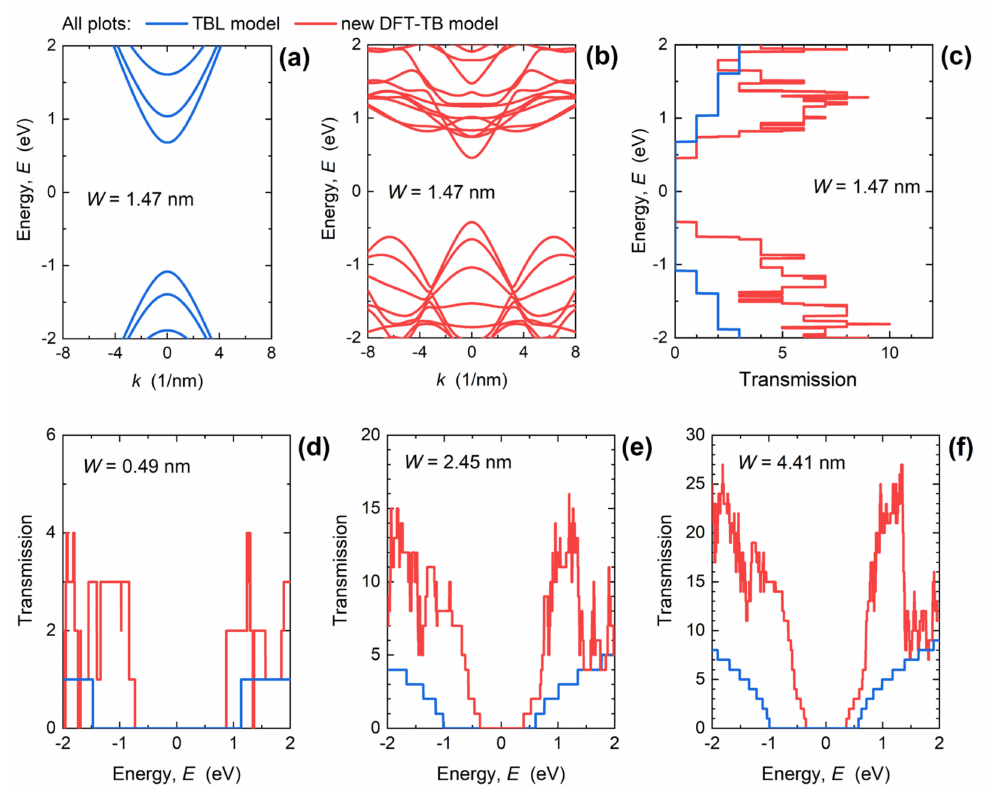
Figure 4. Dispersion obtained by ( a ) TBL and ( b ) DFT-TB model, and ( c ) transmission for the 1.47 nm-wide PNR. Comparison of transmission functions obtained with the two TB Hamiltonian models for W of ( d ) 0.49 nm, ( e ) 2.45 nm, and ( f ) 4.41